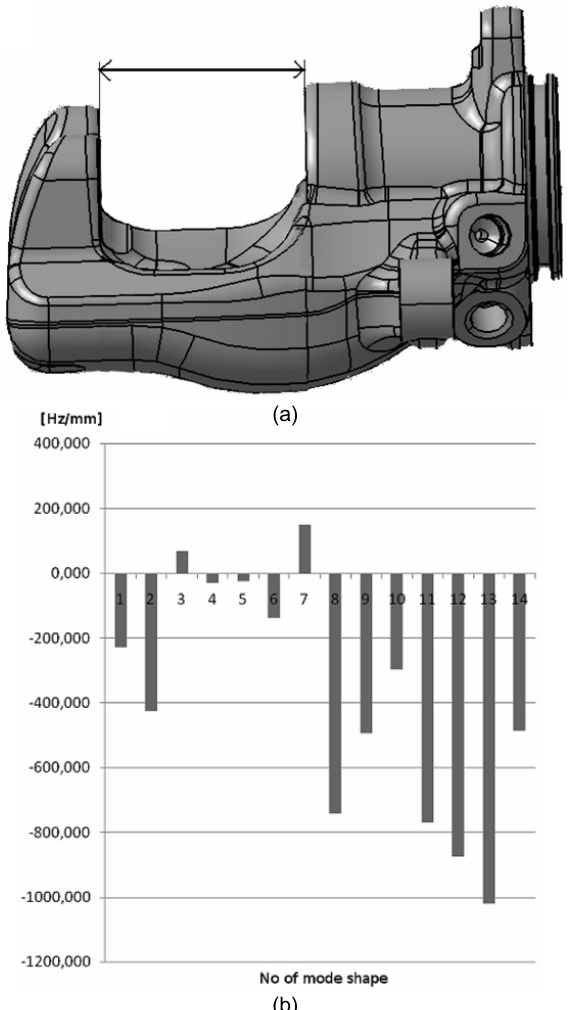
Fig. 10. The sensitivity of caliper natural frequencies to geometry variation (a spacing of a caliper): a) a view of the caliper b) sensitivity analysis results. parameters), repeatability of experiments (statistical assessment), variability of parameter estimation (various algo- rithms and/or their parameters), repeatability of parameter estimation (subjective decision of operators, statistical assessment) as well as variability related to manufacturing